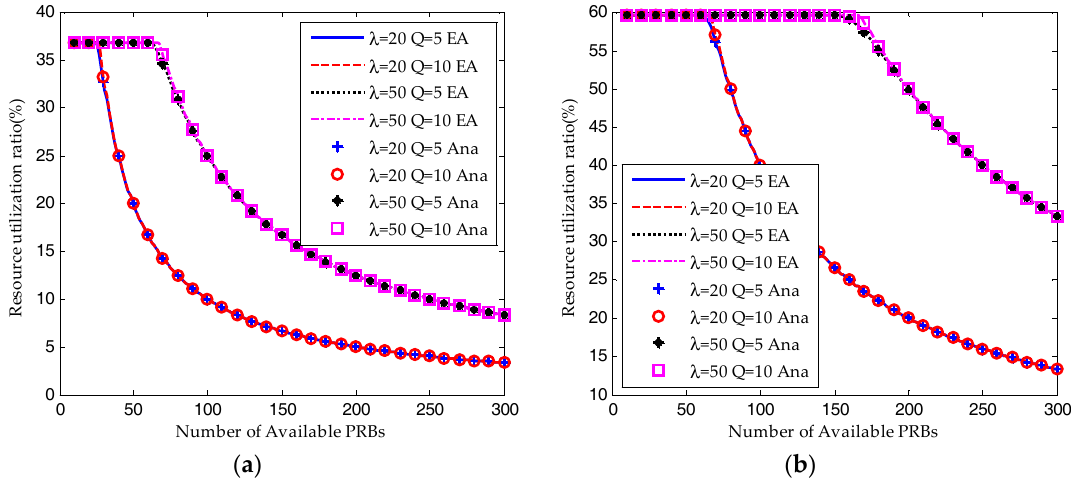
Figure 8. Comparison of resource utilization ratio between equilibrium analysis and iterative analytical results (W BO = 0): ( a ) S-ALOHA protocol; ( b ) TDMA protocol.